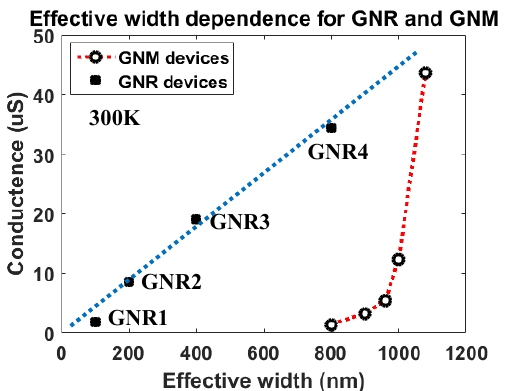
Figure 10. Effective width dependence for the conductance of GNR and GNM devices at 300K. The blue dotted line is the linear fitting for the GNR devices. GNR1, GNR2, GNR3, and GNR4 were the suspended GNRs with 100/200/400/800 nm width and 500 nm length.